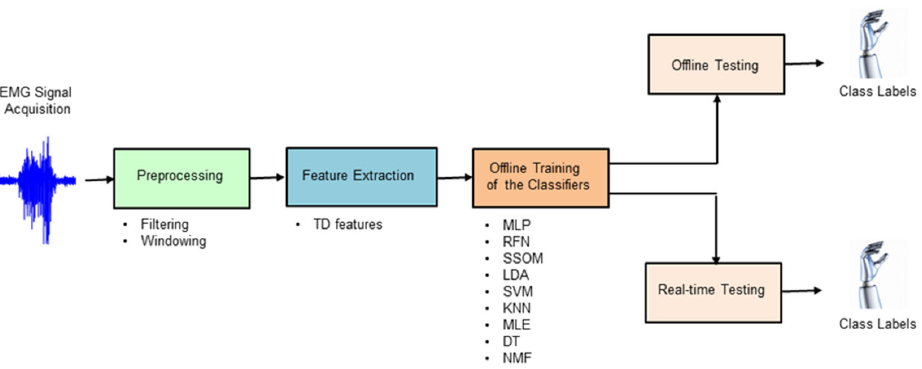
Figure 2. Block diagram illustrating the processing stages used in this study to decode hand movements, both offline and in real ‐ time.